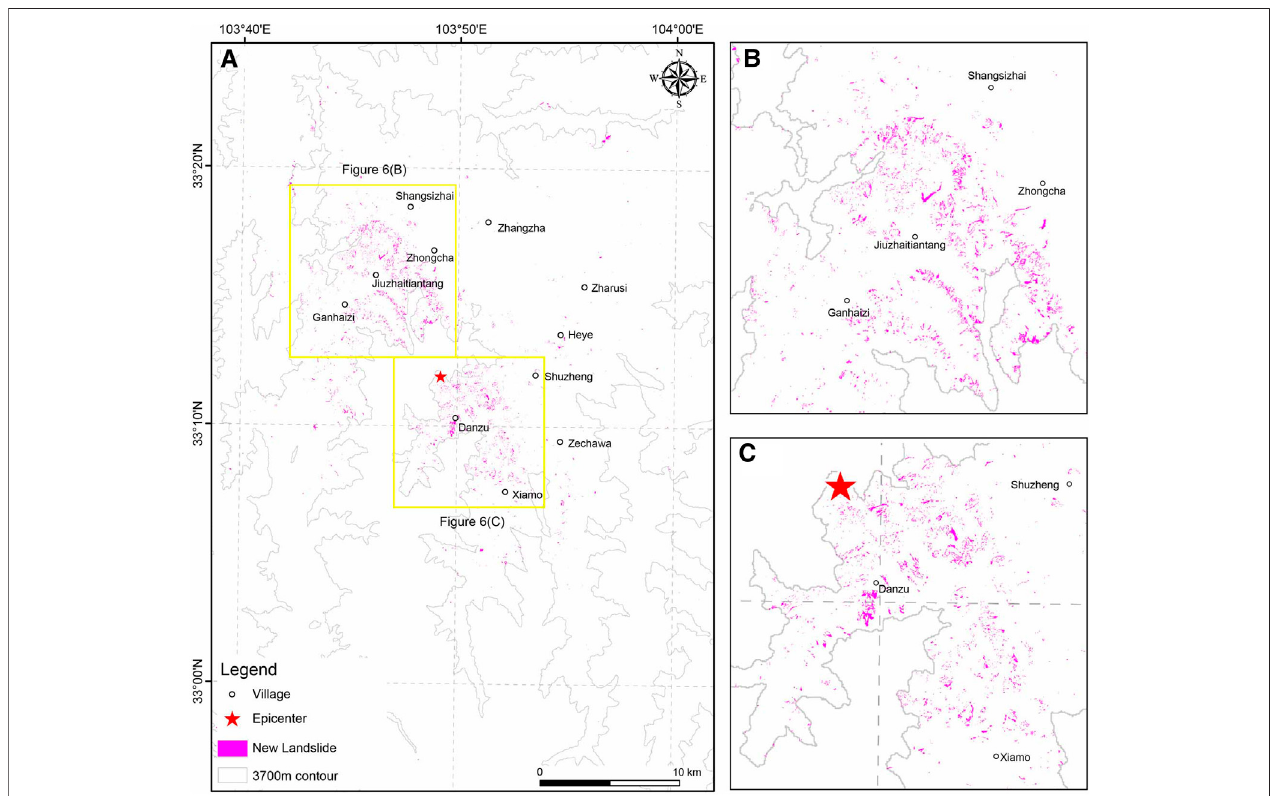
FIGURE 6 | Inventory map of new landslide area (A) New landslide map (B) New landslide map of Jiuzhaitiantang (C) New landslide map of Panda Lake.